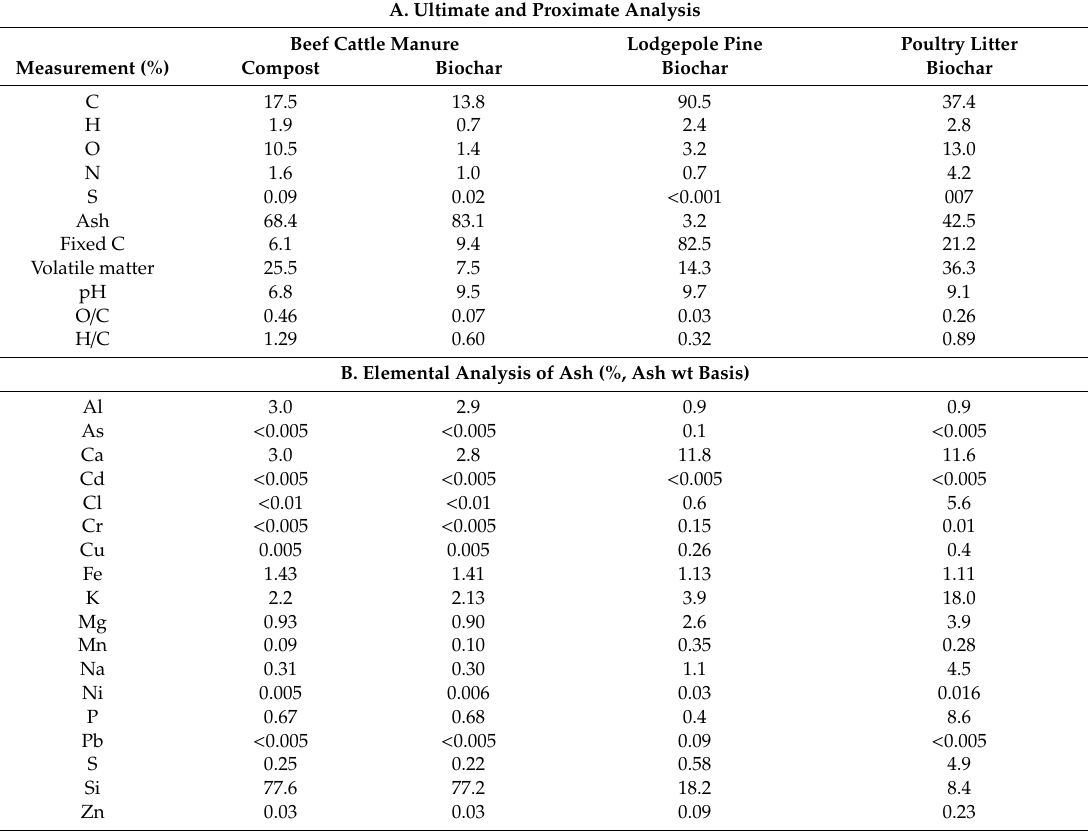
Table 2. Chemical and physical properties of compost and biochars